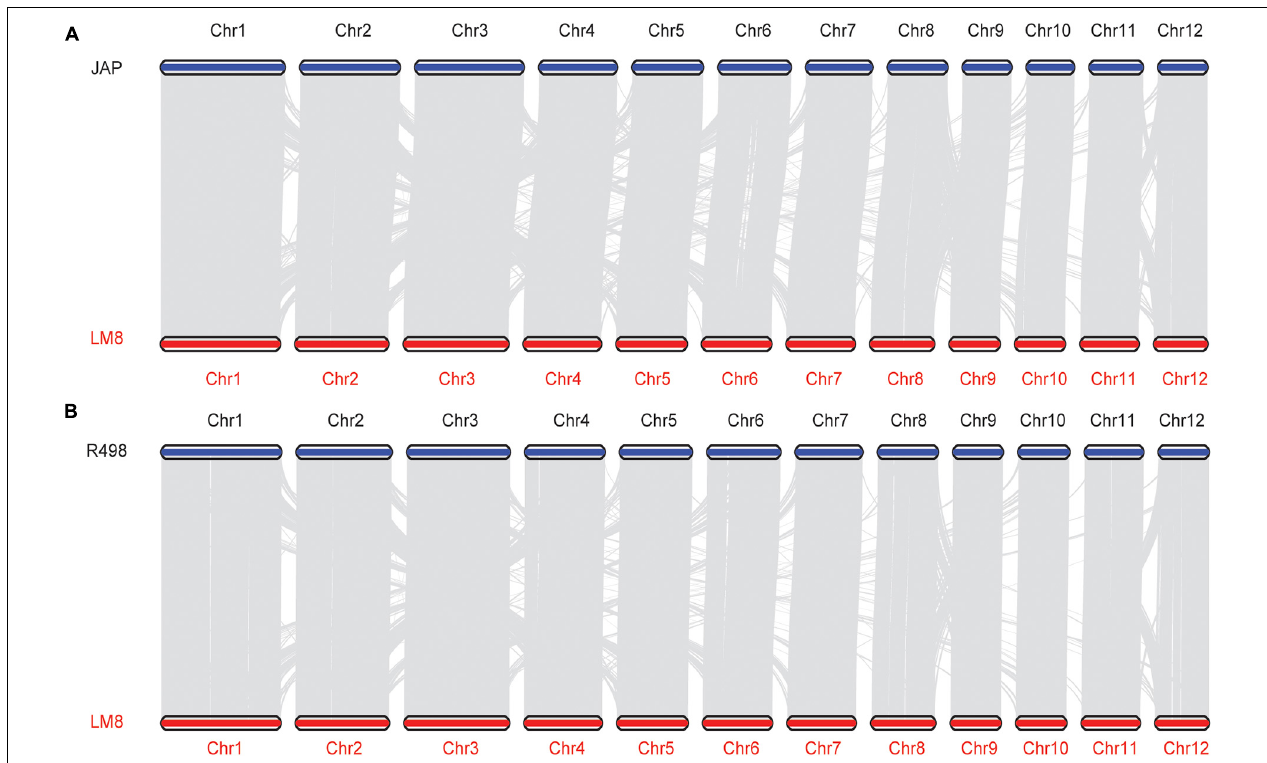
FIGURE 6 | Collinearity between LM8 and two cultivated rice (JAP and R498) genomes. (A) Collinearity between JAP and LM8. (B) Collinearity between R498 and LM8.